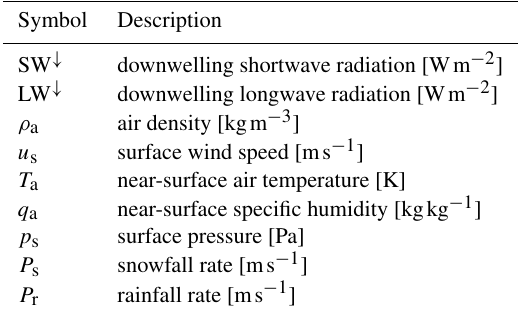
Table 2. Atmospheric forcing fields needed as input for this